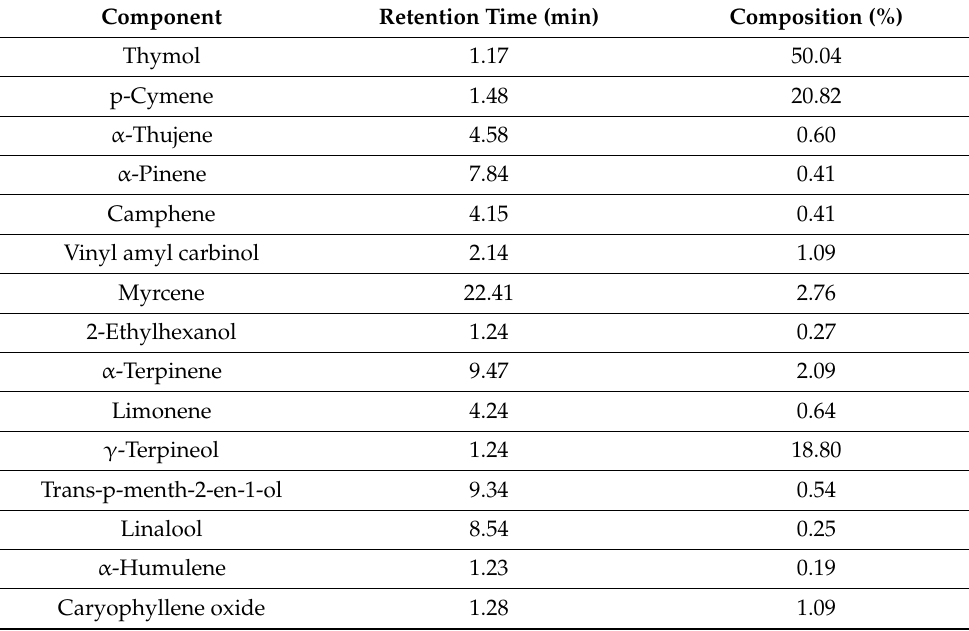
Table 6. Identification of Thymus vulgaris aqueous extract bioactive